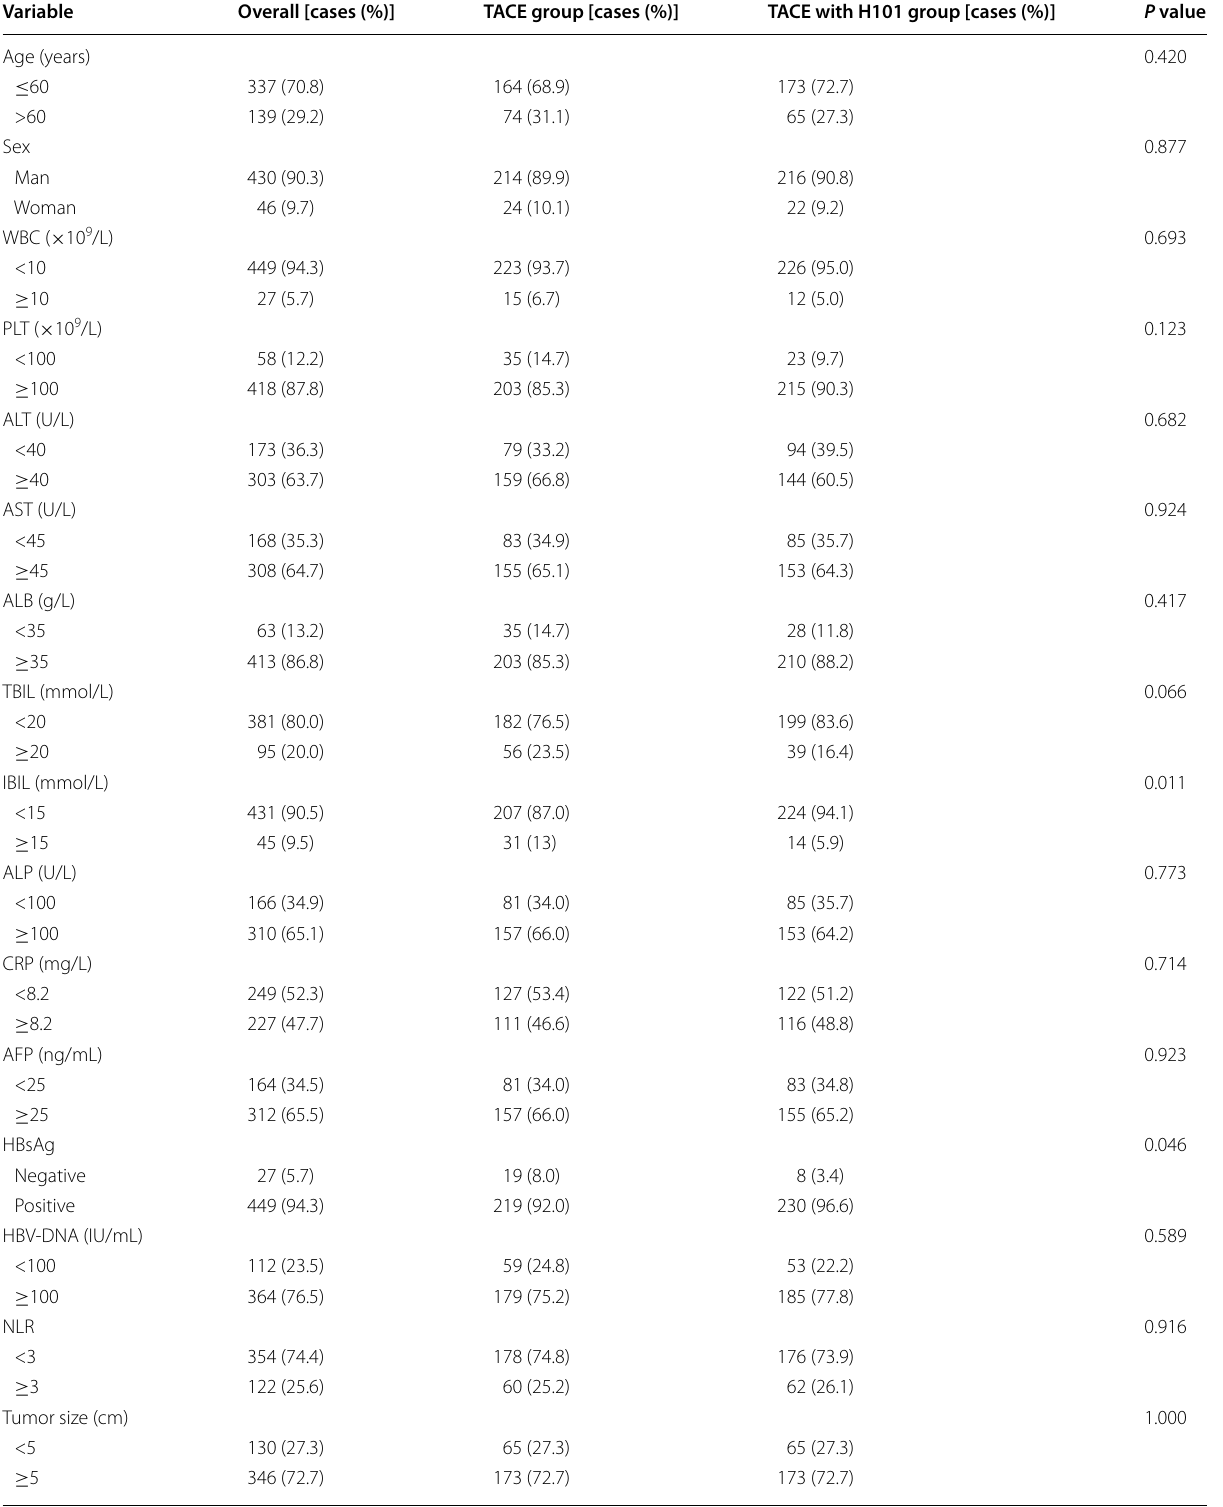
Table 1 Clinical and radiologic characteristics of patients with intermediate to advanced hepatocellular carcinoma (HCC) who received transarterial chemoembolization (TACE) with or without